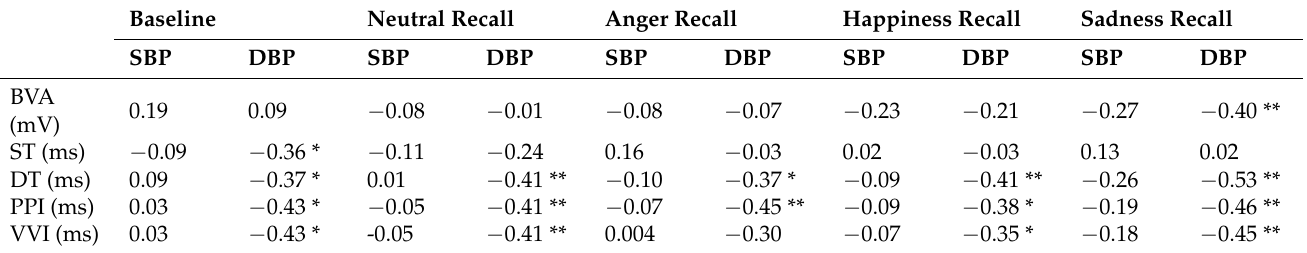
Table 3. The correlations between photoplethysmography parameters and blood pressure under different experimental stages (n =